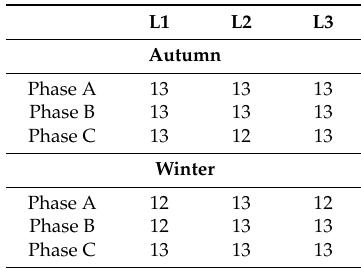
Figure 7. Wavelet of the currents flowing in L1, L2, L3 for the entire period. ( a – c ) phases of the line L1; ( d – f ) phases of the line L2; ( g – i ) phases of the line L3. Table 2. Number of Intrinsic Mode Function (IMFs) for each current, for each distribution circuit, for each season.